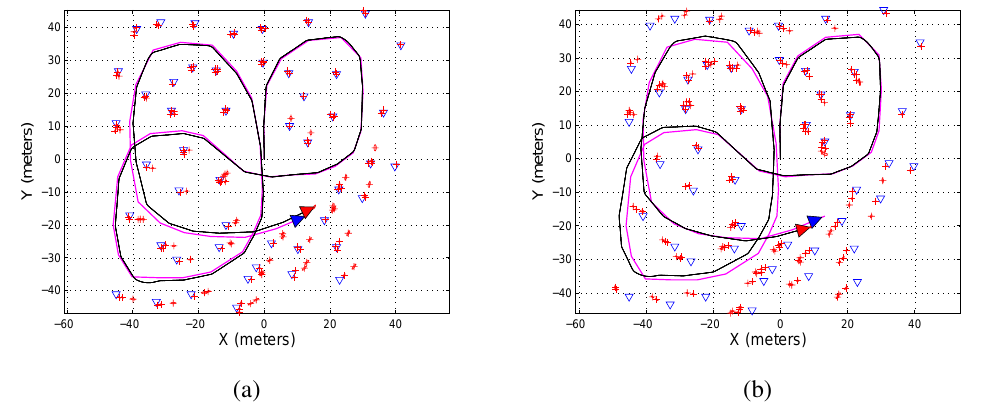
Figure 5. Map reconstruction of the environment using the entropy feature selection criterion on the EKF-SLAM. (a) Shows the map reconstruction when the information difference gate was set to δ = 0 . 2 ; (b) shows the map reconstruction when the information difference gate was set to δ = 0 . 4 . As it can be seen, the map precision depends on the selection of the information difference gate, which in turn is related to the design of the algorithm. The path traveled by the mobile robot is represented in a solid black line and the path estimated by the SLAM in solid magenta; the features are represented by blue triangles and the ellipses of uncertainty associated with each feature are in solid red.